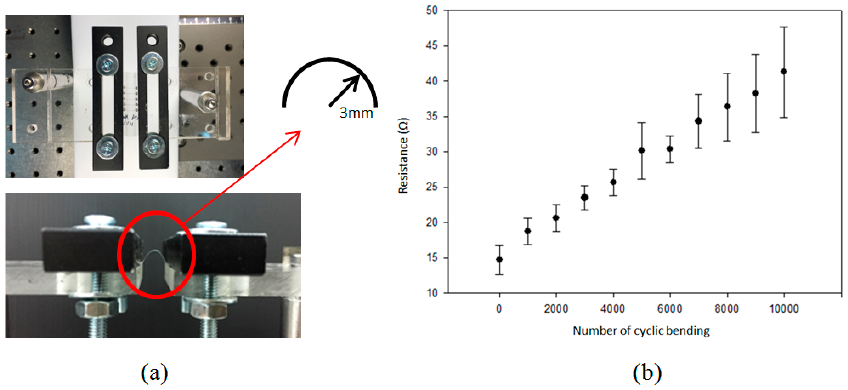
Figure 8. Demonstration of conductive silver line fabricated by LDSP on the transparent PET substrate.